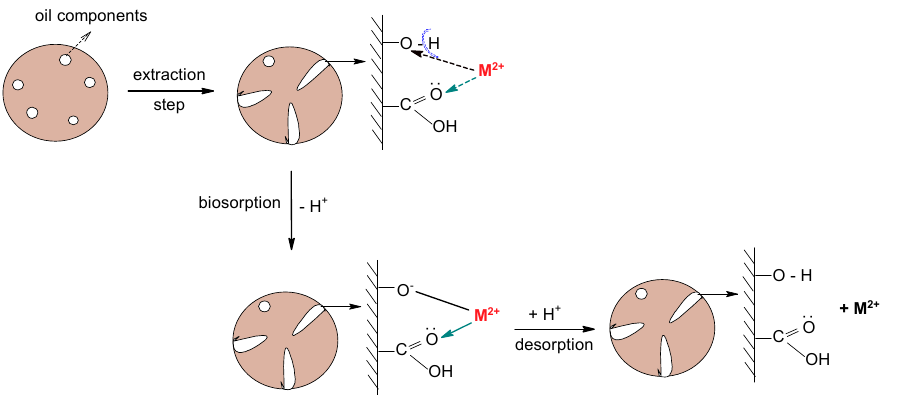
Figure 7. Schematic representation of the biosorption mechanism of Pb(II) and Hg(II) ions on RWB biosorbent.